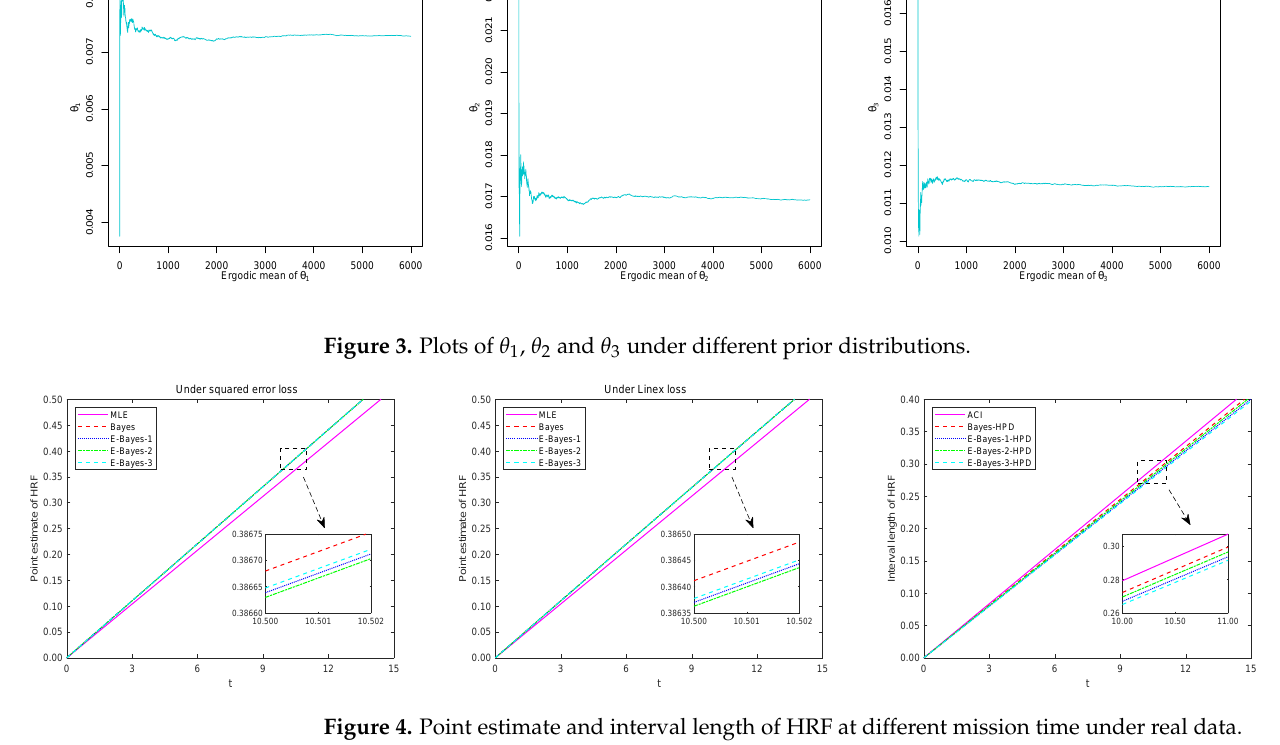
Figure 4. Point estimate and interval length of HRF at different mission time under real